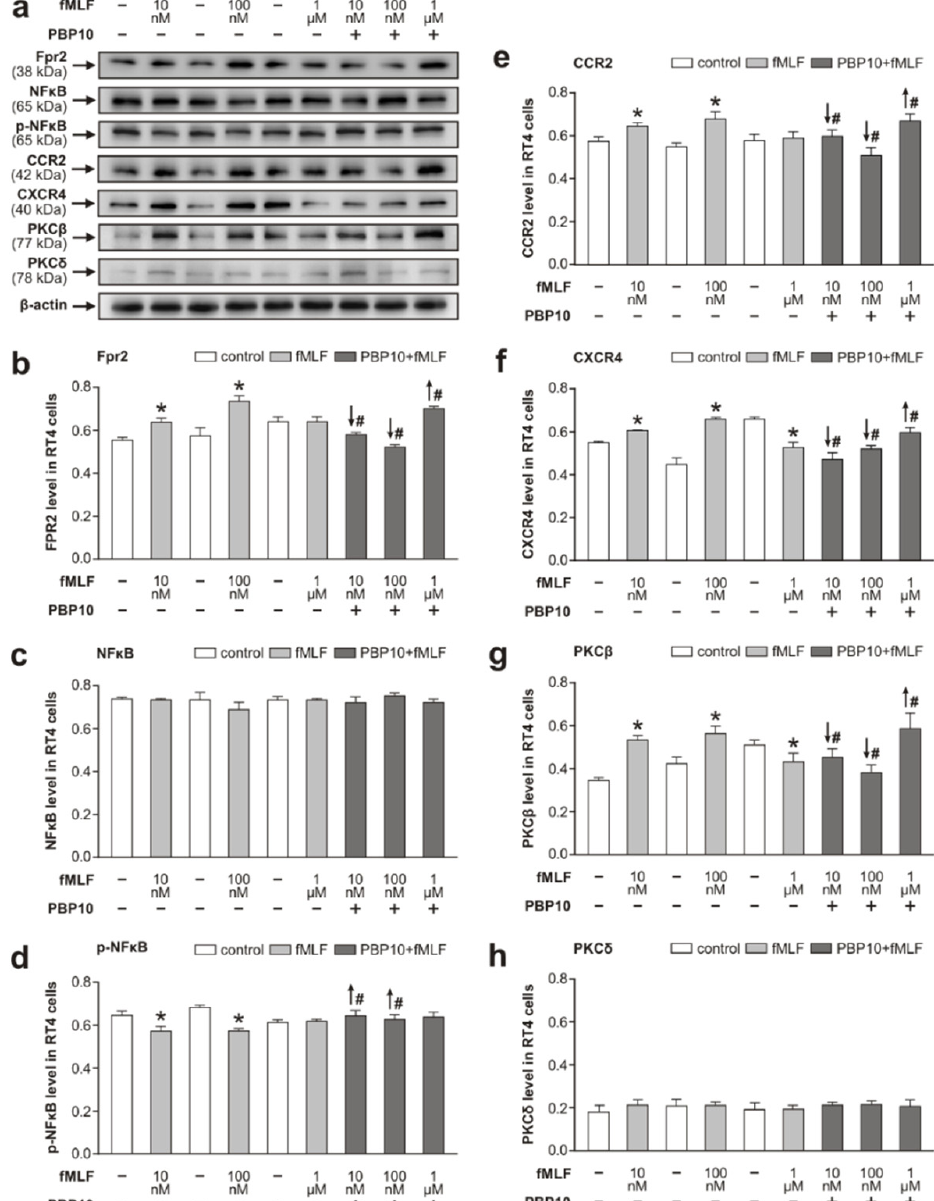
Figure 4. Parallel dynamics of Fpr2 and chemokine receptors CCR2 and CXCR4 and their signaling. Western blot analysis of Fpr2, NF κ B, p-NF κ B, CCR2, CXCR4, PKC β , and PKC δ in RT4-D6P2T cells